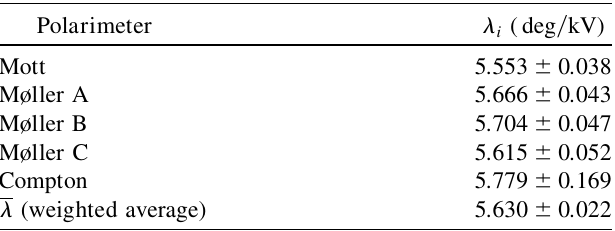
TABLE III. (cid:12) determined by Eq. (4) for each polarimeter i and the weighted average, (cid:12) .